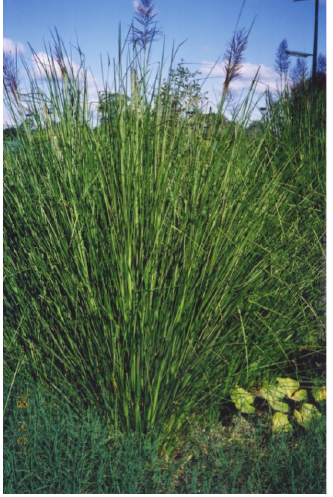
Figure 1: Vetiver grass ( Chrysopogon zizanioides L.